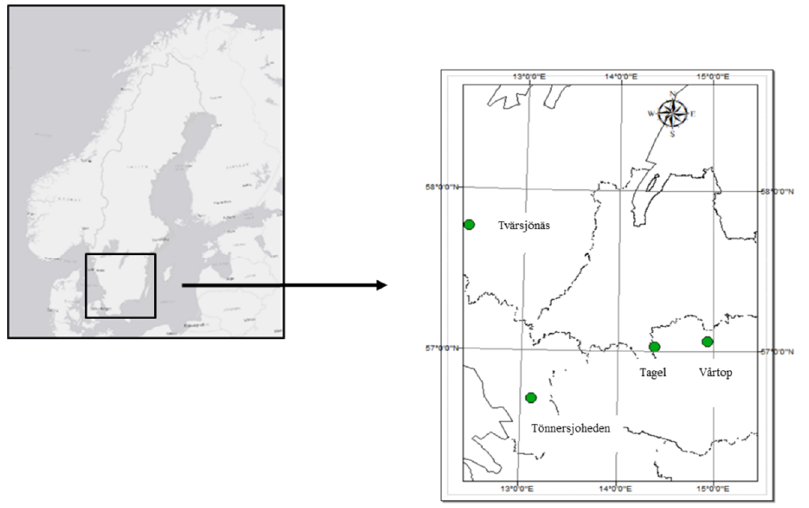
Figure 1. The pre-commercial-thinning experiment, located in four sites in southern Sweden. Each experimental site is marked with a green dot. The site index of Norway spruce (H100) varied between 32 and 34 depending on the site [42].